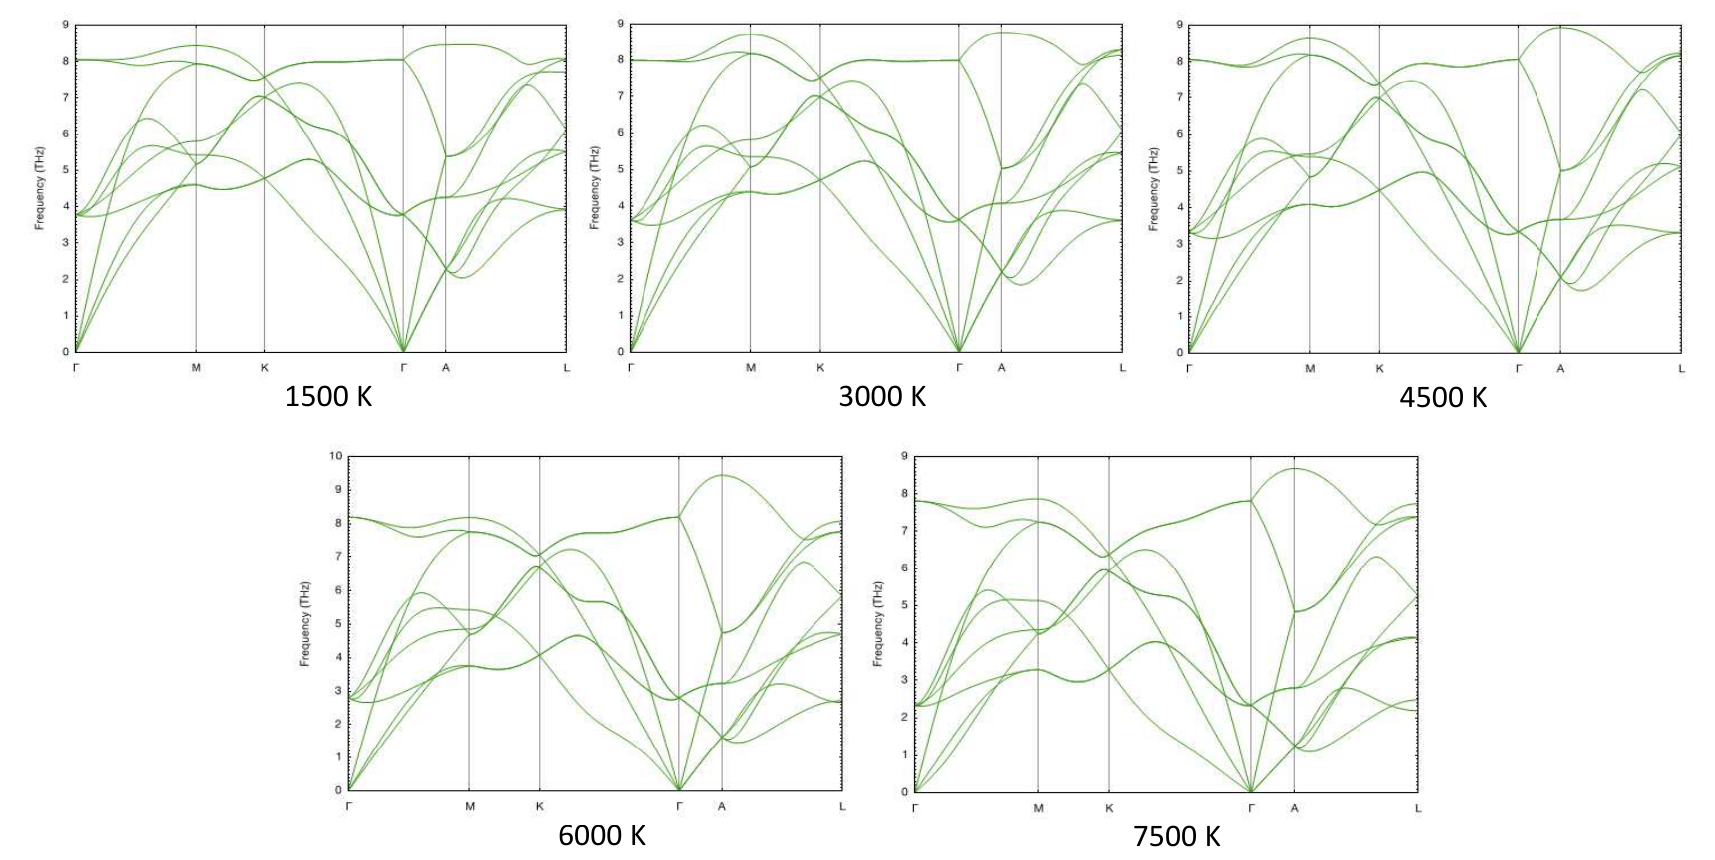
Figure 13. Phonon spectra of fcc-Re as functions of T at a fixed density of 25.1 g/cc.